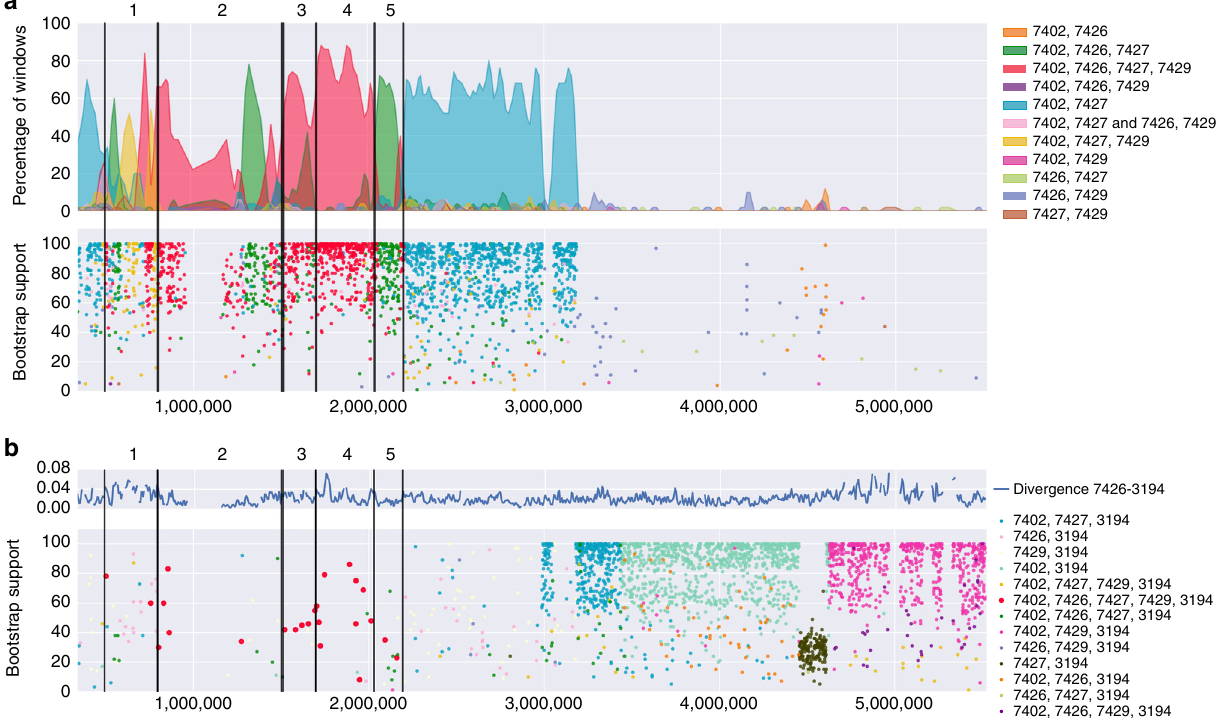
Fig. 4 Phylogenetic signal over chromosome 3. SNPs from all 21 N. intermedia and 5 N. metzenbergii strains were split into non-overlapping windows each containing 50 variable sites, and a phylogenetic tree was inferred using the BioNJ algorithm in PhyML for each window. a The windows were then classi fi ed based on which of the four Sk-2 strains were grouping together in the tree. All Sk-2 strains share inversions 1 – 5 and in the absence of recombination the entire non-recombining region should form a monophyletic cluster (shown in red). When three or fewer Sk-2 strains group together, this indicates that recombination has happened (other colors). Top panel show the percentage of each monophyletic grouping in bins of 50 trees. The bottom panel shows the bootstrap support for the monophyletic group identi fi ed in each tree. Black bars show the borders of the fi ve major inversions. In inversions 3 and 4 (as indicated by the numbers above the plot), the main signal is of all four strains grouping together, indicating no recombination. In inversion 5 and in a section of inversion 2, strain 7429 no longer groups with the other three (marked in green), consistent with a recombination event. The breakpoints of all inversion show the red grouping, indicating that the recombination events did not span several inversions. b Phylogenetic signal of monophyly of Sk-3 together with Sk-2 . Top panel shows pairwise divergence between Sk-2 strain 7426 and Sk-3 strain 3194, in 10 kb sliding windows with a 2 kb step. Bottom panel show windows where Sk-2 and Sk-3 form a monophyletic group. Colors indicate which Sk-2 strains (7492, 7426, 7427, 7429) group with Sk-3 (3194) and the y axis indicates bootstrap support for that speci fi c group. In the non-recombining region of chromosome 3, no strong signal for monophyly could be detected with only a smaller number of low bootstrap windows. The large clusters of windows on the right which show a signal of Sk-2 - Sk-3 monophyly are the product of the backcrossing of the spore killer strains to the Taiwan genetic